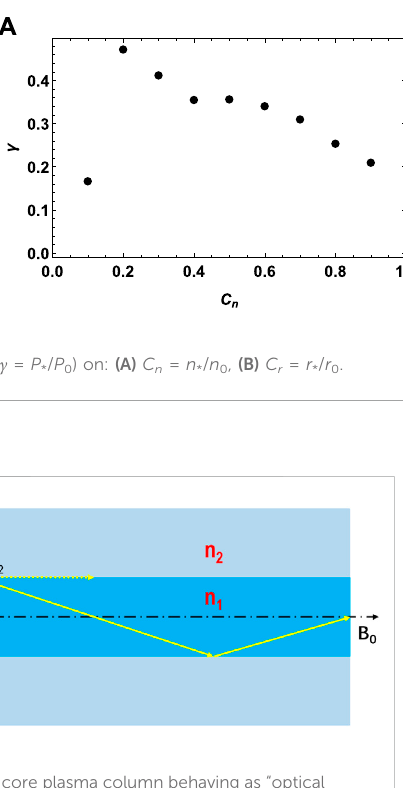
FIGURE 15 Illustration of blue-core plasma column behaving as “ optical fi ber ” for electromagnetic